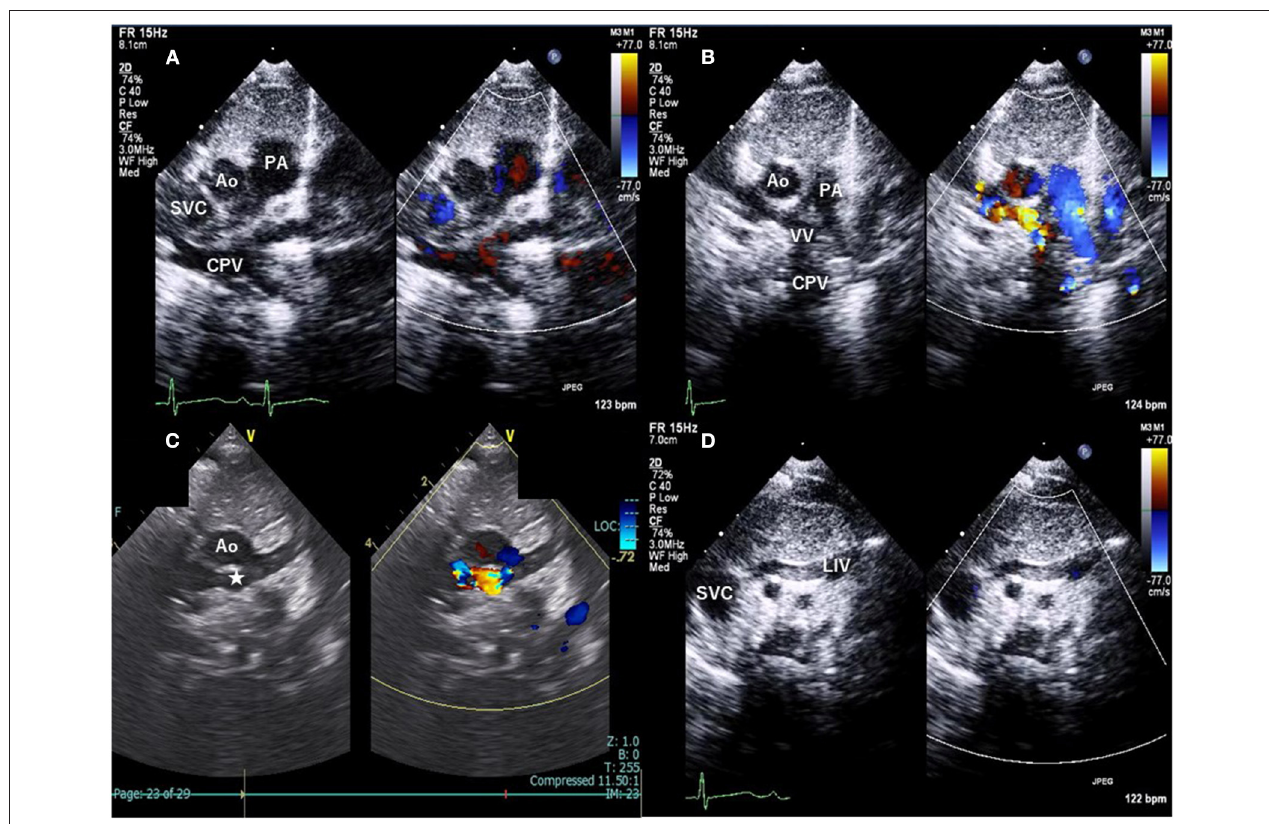
FIGURE 1 | Suprasternal notch view of transthoracic echocardiography with color Doppler. (A) The pulmonary venous confluence (CPV) posterior to the left atrium. (B) The vertical vein (VV) originating from the CPV. (C) The anomalous vessel (asterisk) flowing from left to right behind the ascending aorta. (D) The left innominate vein in its normal position is not so dilated. Ao indicates aorta; PA, pulmonary artery; SVC, superior vena cava; LIV, left innominate